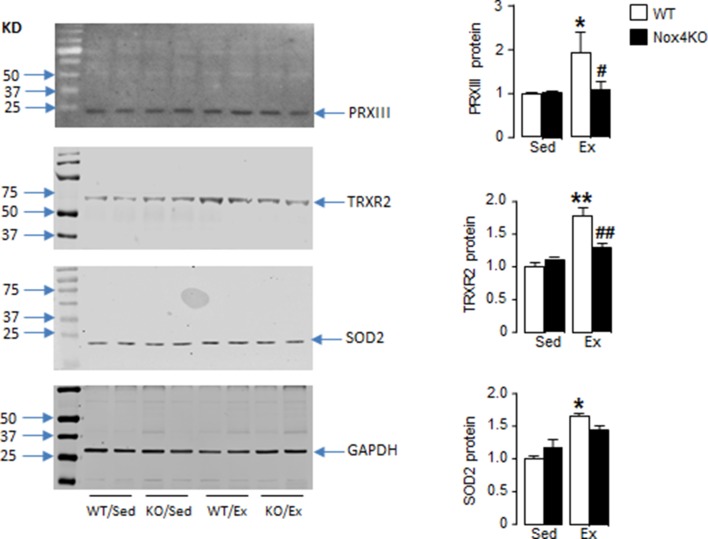
Nox4 is required for increase in mitochondrial antioxidant capacity with exercise.Peroxiredoxin III (PRXIII), thioredoxin reductase-2 (TRXR2) and superoxide dismutase-2 (SOD2) in the hearts of Nox4-null and littermate wild-type control mice (WT) after acute exercise (Ex). Mean data from n = 4–6/group are shown on the right. *p<0.05, **p<0.01 vs respective sedentary controls (Sed); #p<0.05, ##p<0.01 vs WT/Ex, 1-way ANOVA followed by Tukey post hoc analysis.